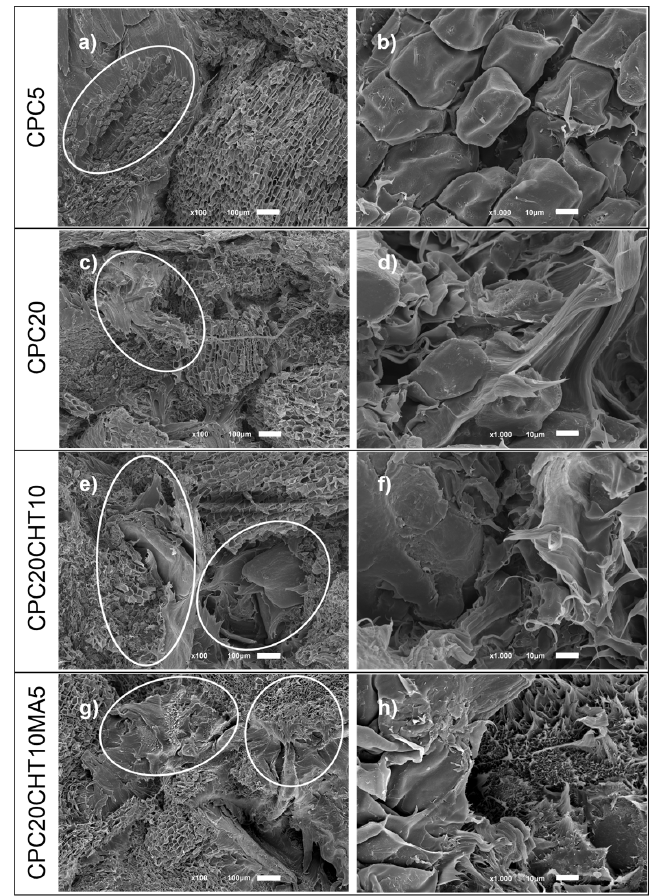
Figure 7. SEM analysis of damage and fracture mode of the biocomposites after tensile tests: ( a , b ) cork pull-out and interface debonding; ( c , d ) matrix deformation and interface debonding; ( e , f ) matrix cracking and cork breakage; ( g , h ) matrix cracking and cork breakage. Magnification at ×100 ( a , c , e , g ) and higher magnification of ×1000 ( b , d , f , h ).